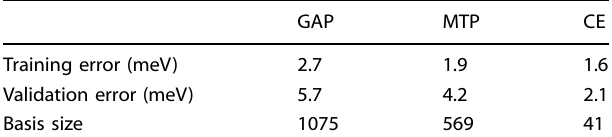
Fig. 6 Most-probable con fi gurations from the nested sampling at 50% Ag. Panel a is at 150 K, while panel b is at 100 K. For both panels a and b , the crystal is viewed edge-on at [111] planes. The lower temperature structure shows clear ordering as stacking planes. This ordering is con fi rmed by simulated XRD in panel ( c ). Ag atoms replaced H atoms to arti fi cially boost the difference in structure factors for the simulation. Table 7. Energy errors in meV on a reference dataset used to train a CE model for